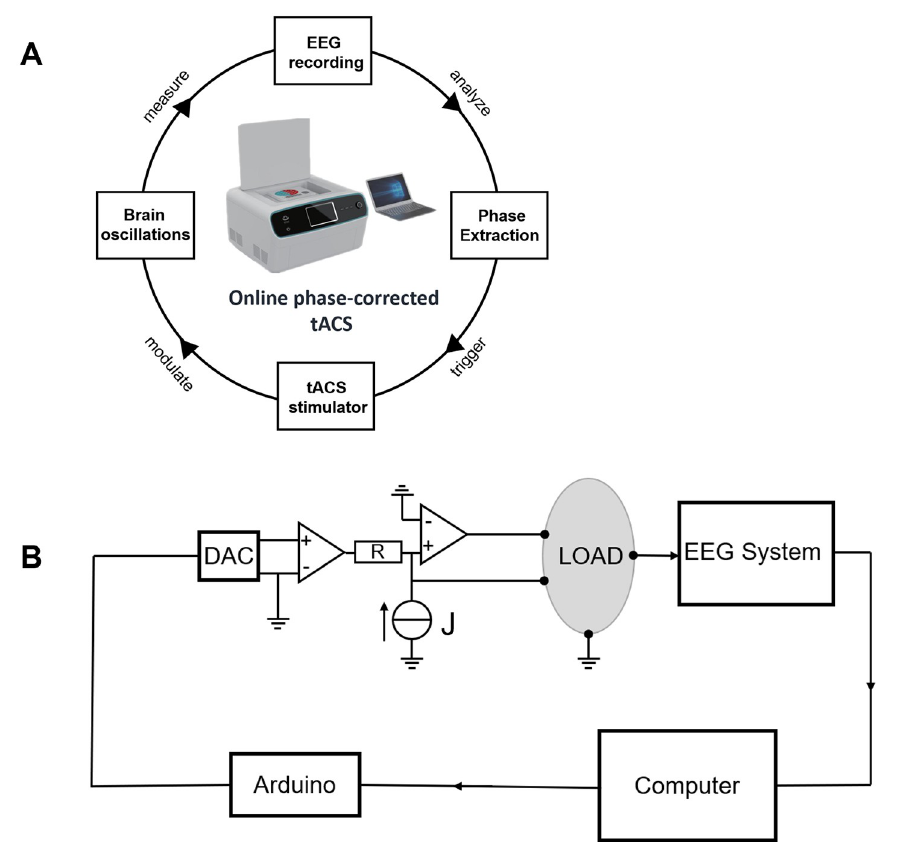
Fig 1. The components of the online phase-corrected tACS system and the design of the tACS stimulator. ( A ) The online phase-corrected tACS system consists of an EEG instrument measuring brain oscillations, a computer extracting the real-time phases of brain oscillations to decide the timing of the tACS stimulator, and a custom-designed tACS stimulator that communicates with the computer to regulate the application of tACS to the human brain. ( B ) The design of the tACS stimulator. The major components of the tACS stimulator include an Arduino Uno microcontroller board, a DAC, a constant-voltage source (J), and 2 operational amplifiers. The appropriate time point to initiate the stimulation (calculated from the computer) is transmitted to the Arduino board. The triangle represents the operational amplifier; R represents the resistance. DAC, digital-to-analog converter; EEG, electroencephalogram; tACS, transcranial alternating current